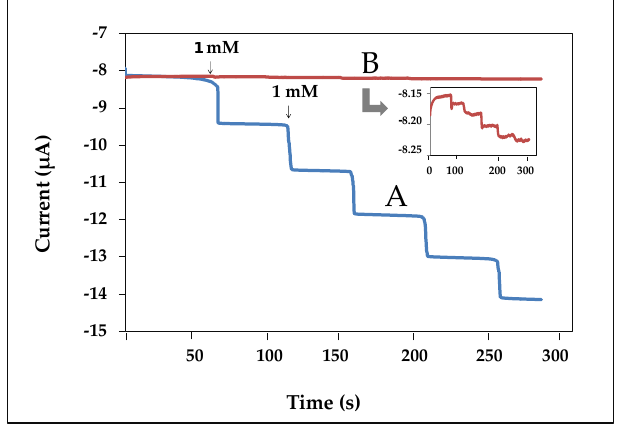
Figure 6. Amperometric responses obtained from nanofiber (A) and thin film (B) modified electrodes to successive addition of 1 mM hydrogen peroxide in phosphate buffer at the applied potential of −0.3 V.